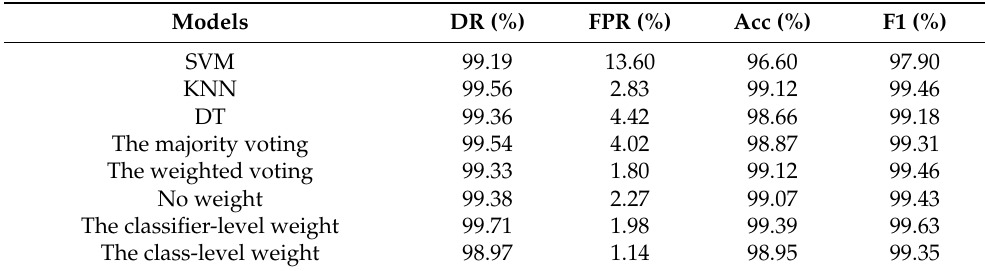
Table 7. Performance comparisons of the base learners and different voting ensemble methods without feature selection on the CICIDS2017 dataset.